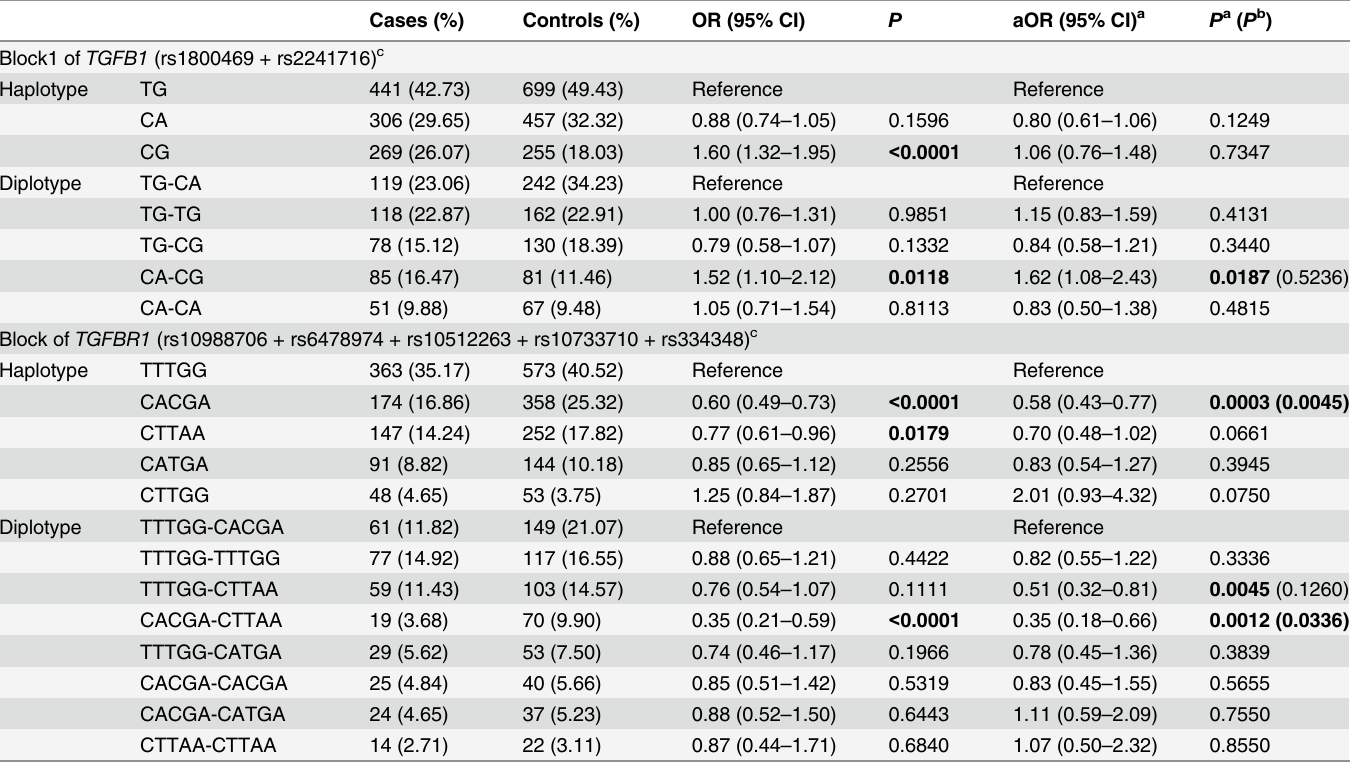
Table 5. Association of haplotypes and diplotypes of TGFB1 and TGFBR1 with EC